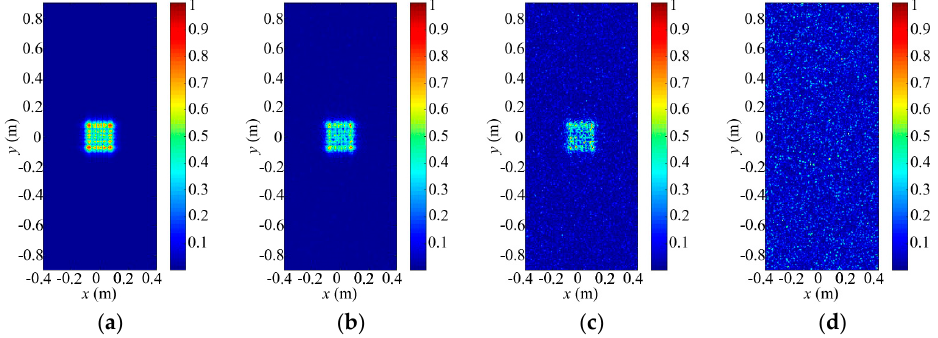
Figure 10. Distributions of the random-modulation incident fields on the left face of the imaging area with the same PPMF and different RPMF phase ranges: ( a ) [ − 0.25 π , 0.25 π ]; ( b ) [ − 0.5 π , 0.5 π ]; ( c ) [ − 0.75 π , 0.75 π ]; and ( d ) [ −π , π ].